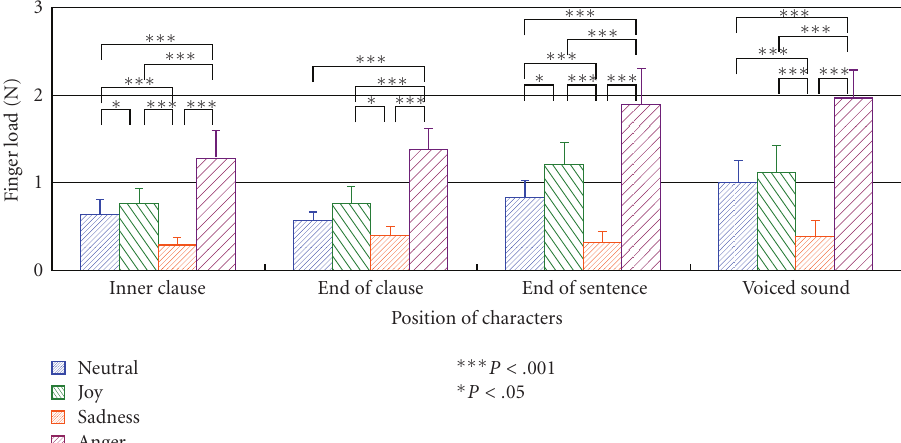
Figure 15: Mean of finger load as a function of emotions and position of characters for two-handed Finger Braille (error bars represent standard